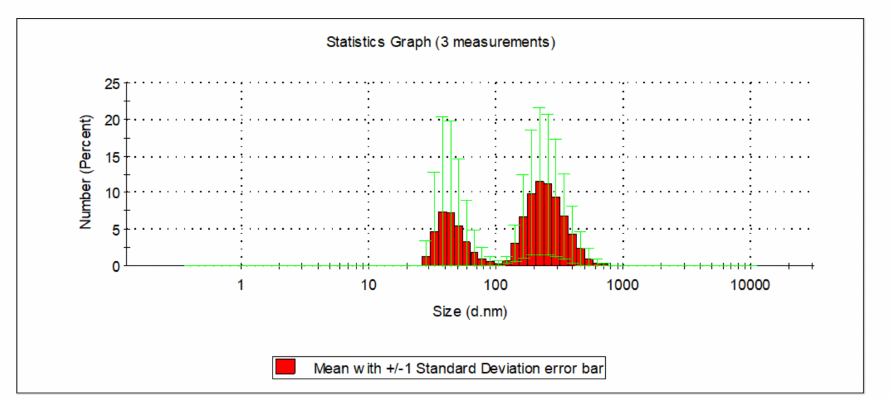
Figure 9. Distribution of particle sizes in water following the filtration process on a dolomite bed.